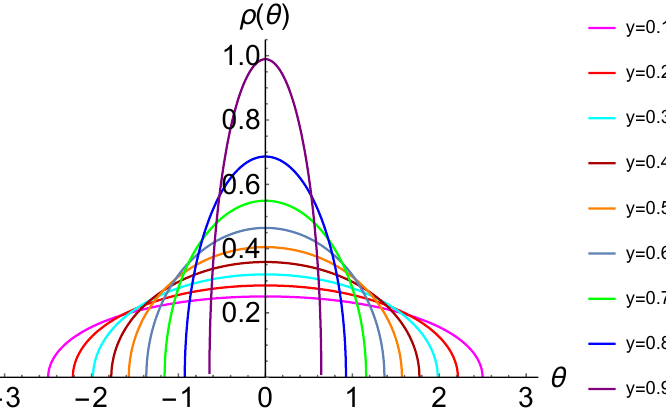
Figure 6: The level density in the ‘t Hooft limit plotted for various values of y . For “ arccos p 2 y ´ 1 q which increases in size with y , with the y ą 0, a gap opens at θ c level remaining a convex